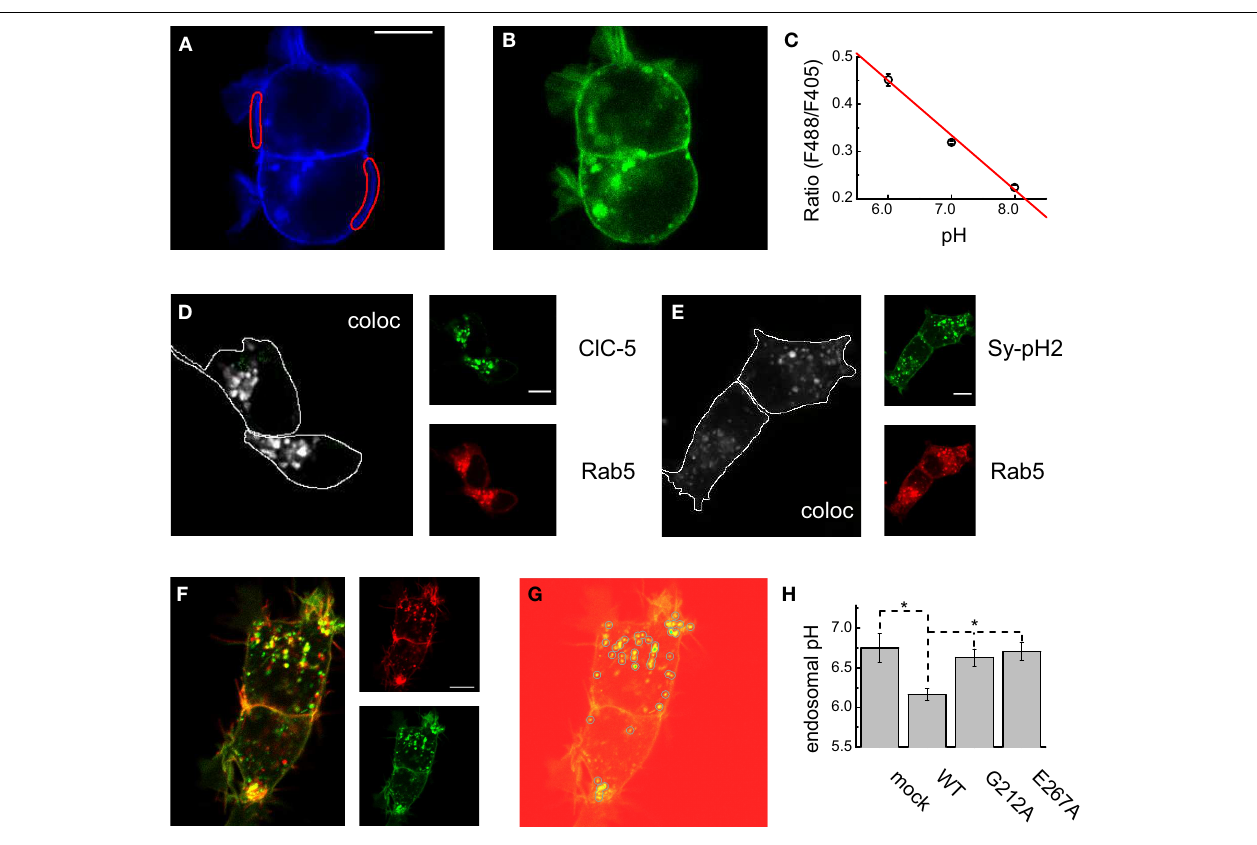
FIGURE 2 | Luminal pH in WT and disease-associated ClC-5-containing endosomes. (A,B) Representative confocal images of cells expressing synpto-pHluorin2 excited at 405nm (A) and 488nm (B) and both detected at a wavelength of 530nm. For the analysis, membrane regions as depicted in (A) were selected and the fluorescence intensity in both channels was measured. (C) Calibration curve constructed from measurements as depicted in (A,B) . The ratios were obtained by taking confocal images from cells ( n = 6 cells for each experimental point) bathed in solutions with pH-s as indicated and containing nigericin to equilibrate the extracellular and intracellular acidity. The calibration curve was constructed by fitting a straight line to the data. (D) Representative cellular distribution and map of the colocalizing pixels for coexpressed Rab5-RFP and ClC-5-YFP expressed in HEK293T cells. (E) Representative cellular distribution and map of the colocalizing pixels for coexpressed Rab5-RFP and synapto-pHluorin2 expressed in HEK293T cells. (F) Representative confocal images as used for determining intravesicular pH. The large image represents the overlay of the fluorescence using 560nm laser line to excite the mCherry attached to